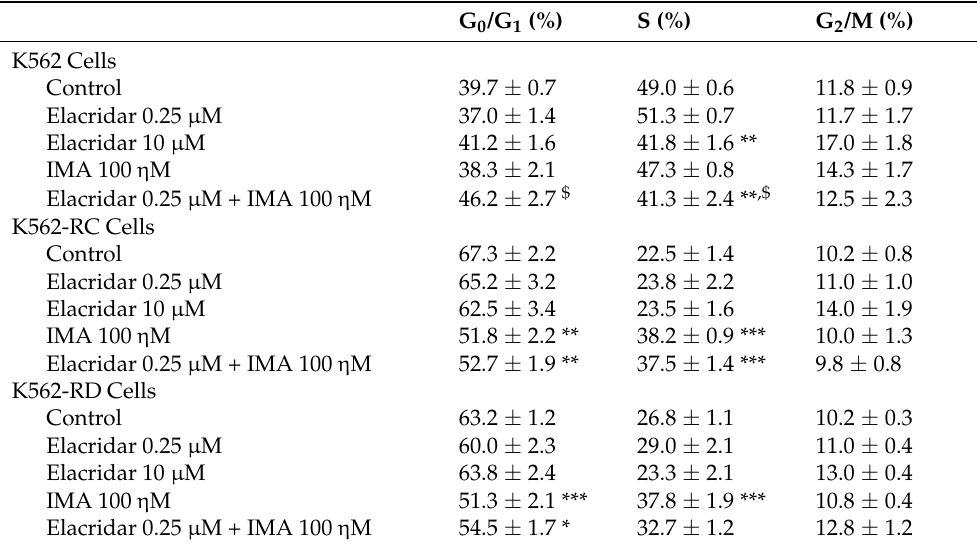
Table 1. Effects of elacridar in the cell cycle of imatinib-sensitive and imatinib-resistant